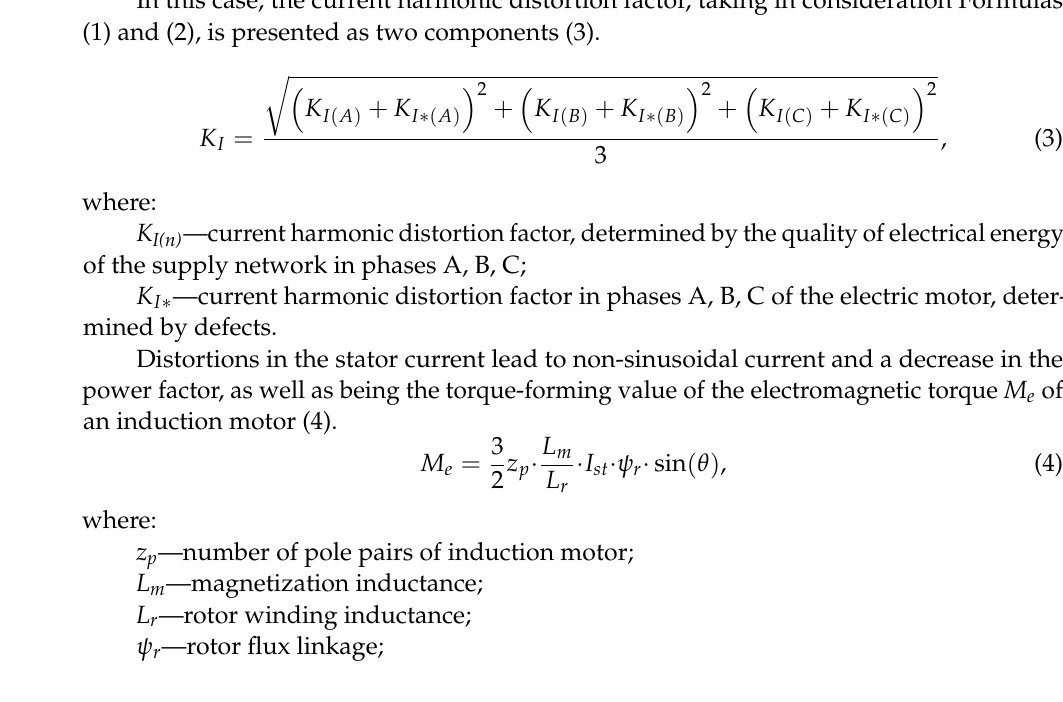
Figure 1. Simplified power supply systems. left—with individual motor control; right—with control by total energy flow; Tr—transformer; QF—circuit breaker; FKD—filter-compensating devices; CS—Hall-effect current sensors compensated type; M—induction motors.